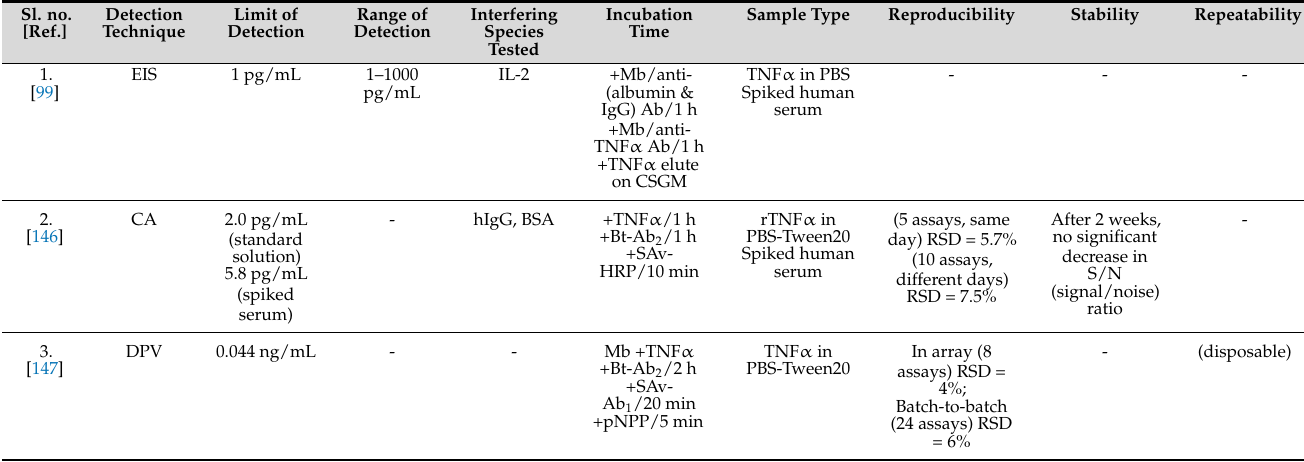
Table 12. Magnetoimmunosensors: Specifications and performance